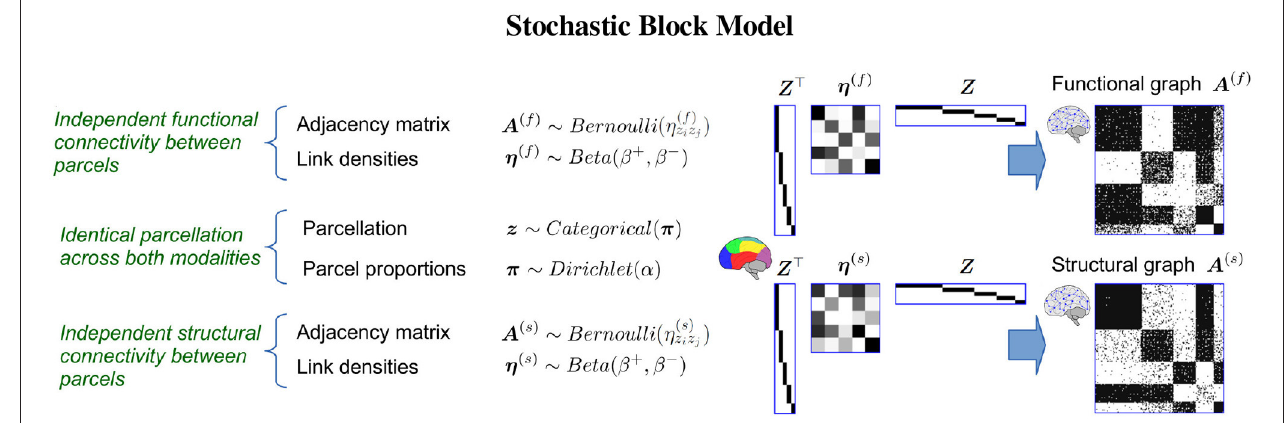
FIGURE 3 | The Stochastic Block Model (SBM) is a generative model capable of discovering a single group-structure from multiple complex networks, i.e., functional connectome A ( f ) and structural connectome A ( s ) . Based on such a shared parcellation z , the model assumes links are independently generated from a Bernoulli distribution such that the probability of observing a link between any two vertices only depends on the modality specific probability of observing a link between the two parcels that the vertices belong to given by the inter parcel (off diagonal elements) and intra parcel (diagonal elements) of the link density matrices η ( f ) and η ( s ) for the functional and structural connectomes, respectively. Under this assumption, the model hence allows a single parcellation to be inferred from multiple networks while accounting for differences in connectivity profiles. Let Z denote a matrix of the clustering z using a one-hot encoding. Notably, the SBM can be considered a lossy compressed representation of the connectomes such that A ( f ) Z ⊤ η ( f ) Z and A ( s ) Z ⊤ η ( s ) Z . ≈ ≈